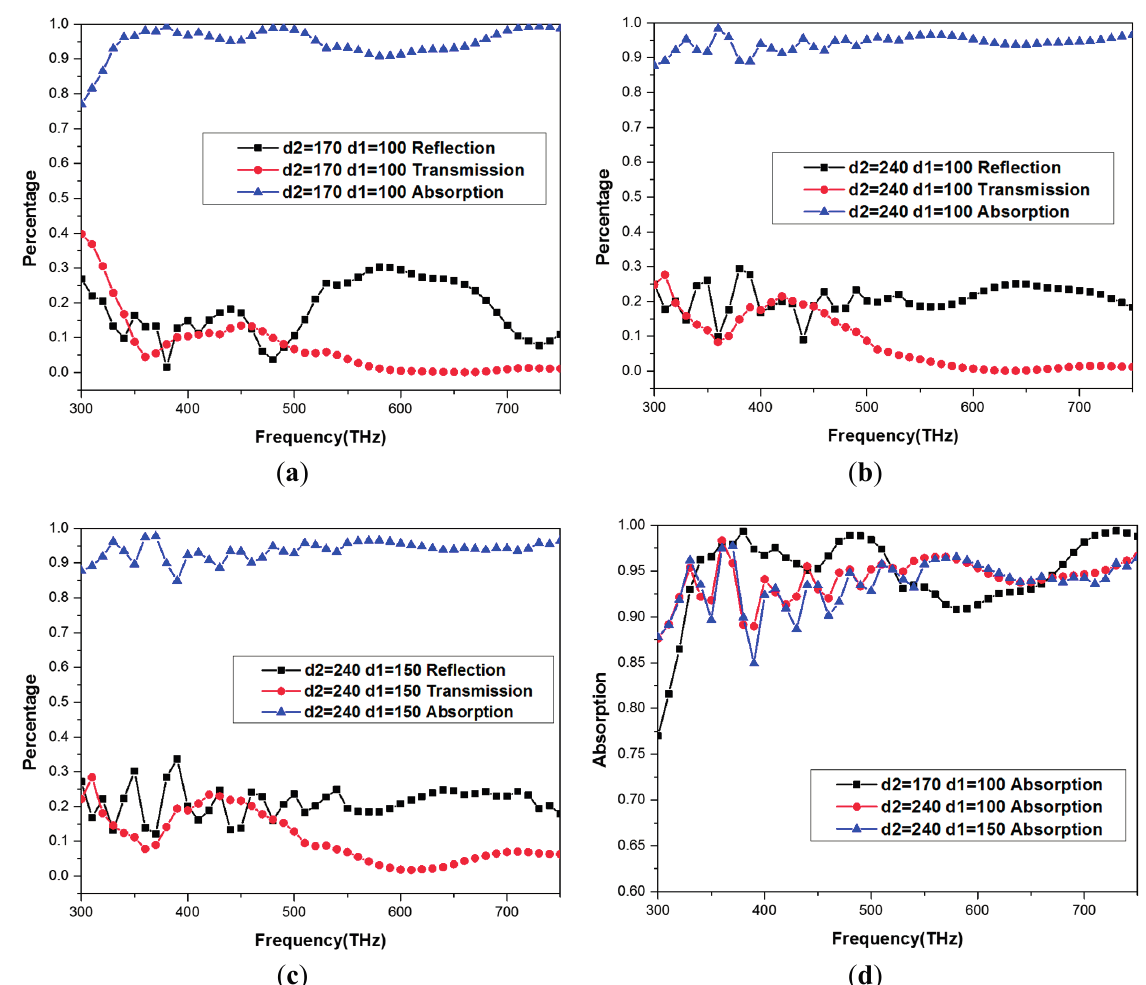
Figure 9. FEM results for absorption rates of varies nanowire